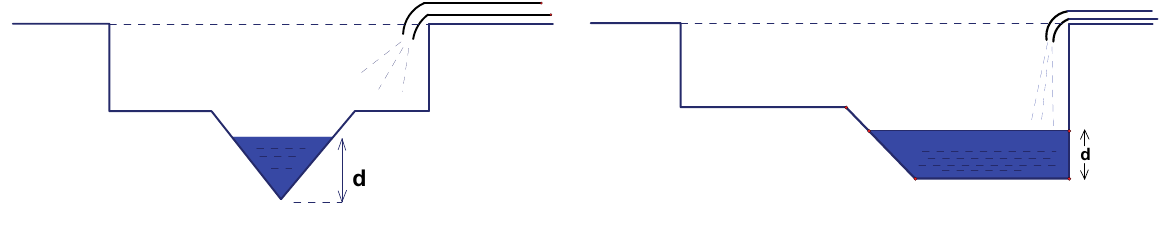
Figure 3 : Possible solutions to the pool